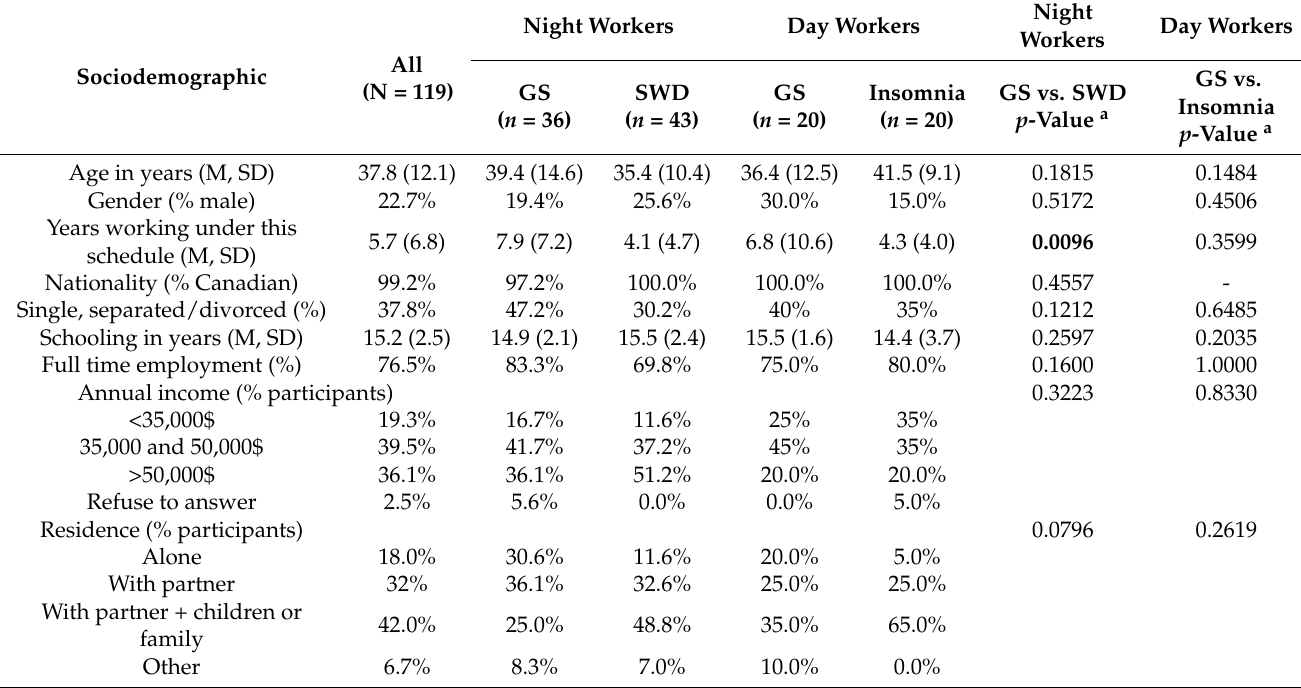
Table 1. Demographic characteristics for night workers and for day